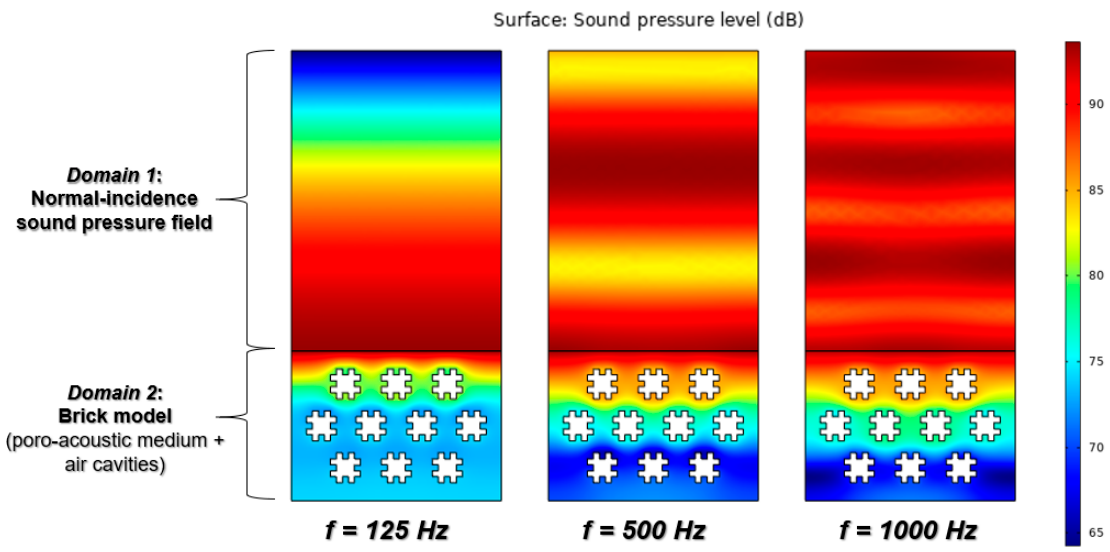
Figure 9. FEA-based acoustic model: sound-pressure-level variation as function of frequency in FHD brick, considering RuC mix as constituent material.